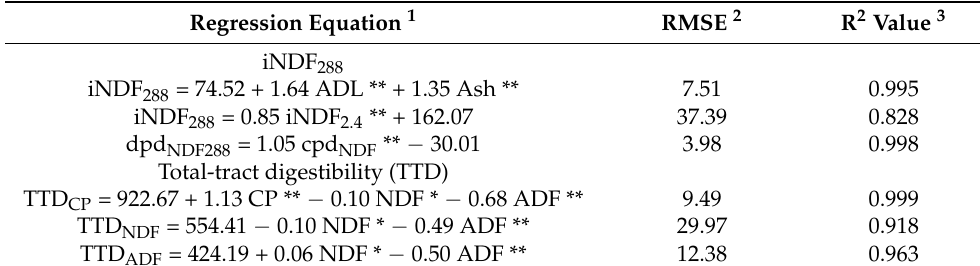
Table 4. The multiple linear regression equations for predicting iNDF 288 and total-tract digestibility based on chemical composition and ruminal degradation kinetics of different forages ( n =